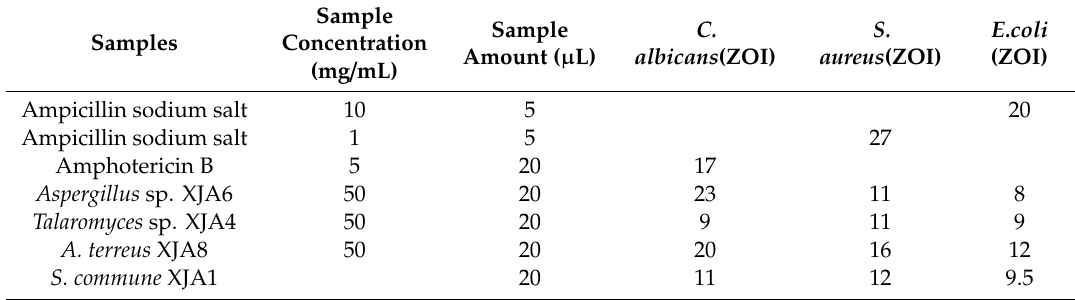
Table 3. Antimicrobial activity of fungal endophytes from V. anthelmintica against some pathogenic bacteria and fungi.